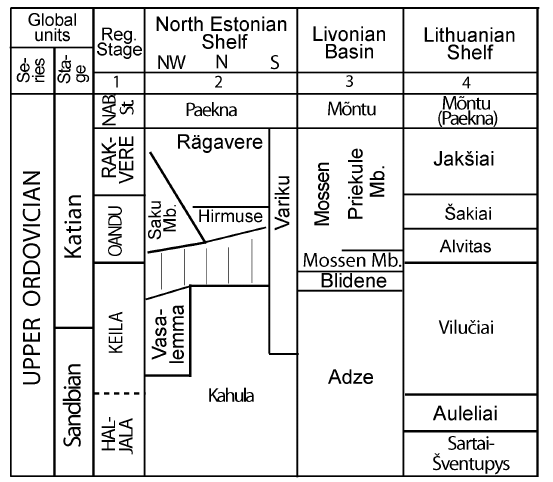
Fig. 1. Correlation of the formations and members of the Sandbian–Katian transitional interval in the East Baltic. Regional Stages (Reg. Stage) (1); correlation of formations and members (Mb.) of the Estonian Shelf and Livonian Basin (2 and 3; Ainsaar et al. 1999; Kröger et al. 2014); correlation of formations identified in the Lithuanian Shelf (Paškevi č ius 1997) (4); Nab. St. – Nabala Stage. For the chitinozoan and conodont biozones see Figs 3 and 4.